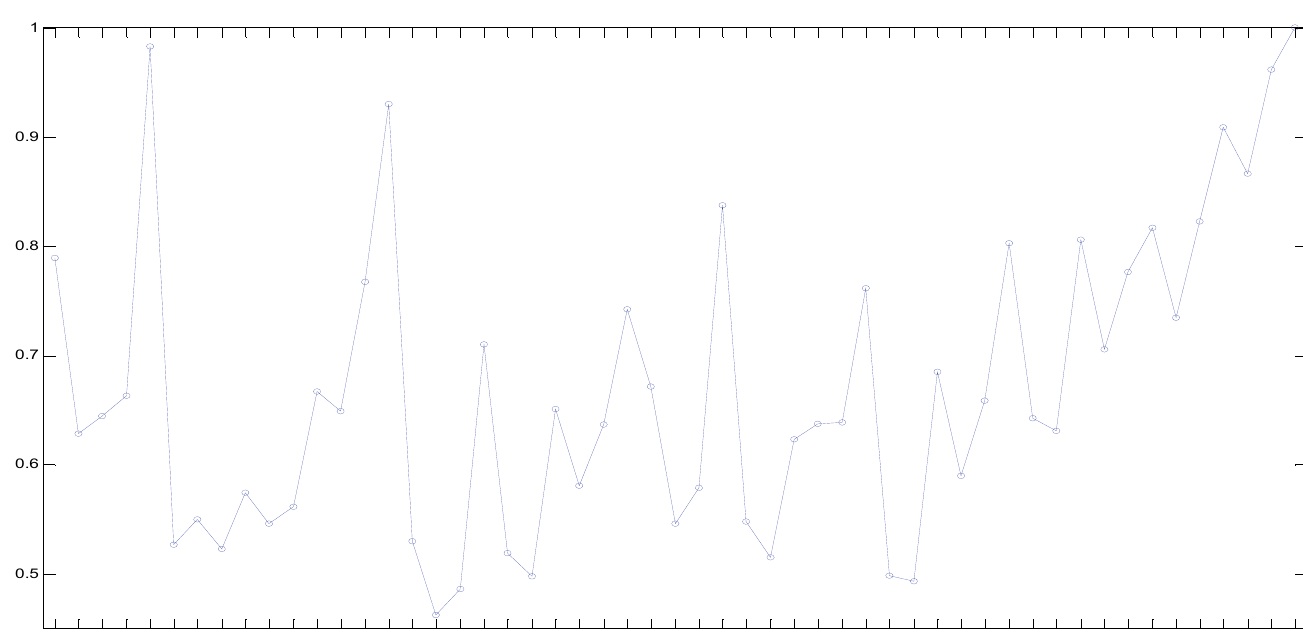
Fig. 4. The polyline showing the normed averaged performance (21) against the ordered sequence of the filter spatial extents for 28 28  images (from Fig. 3).